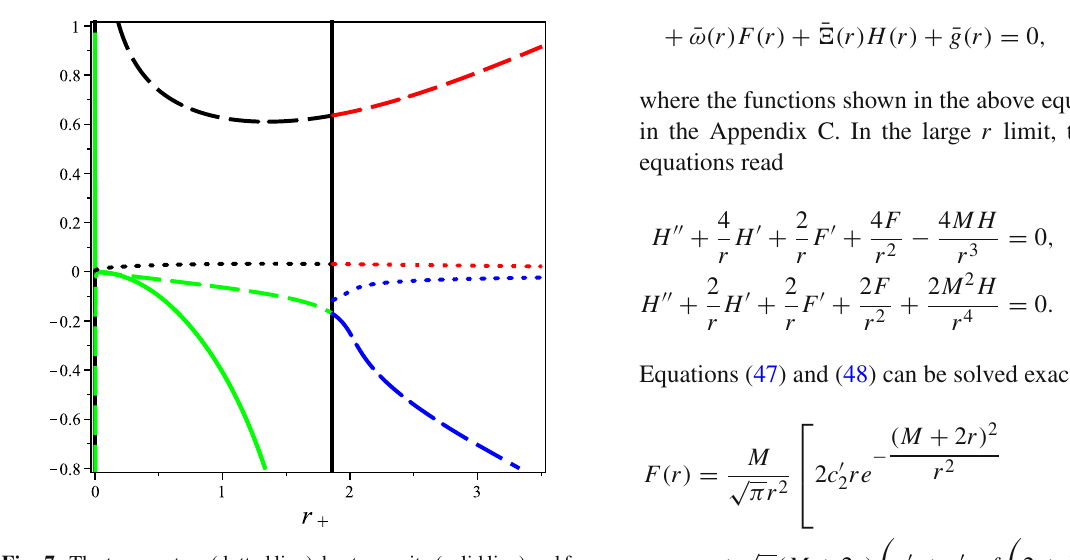
Fig. 7 Thetemperature(dottedline),heatcapacity(solidline)andfree energy (dashed line) as a function of r + for c 1 = − 0 . 25 ,α = 0 .